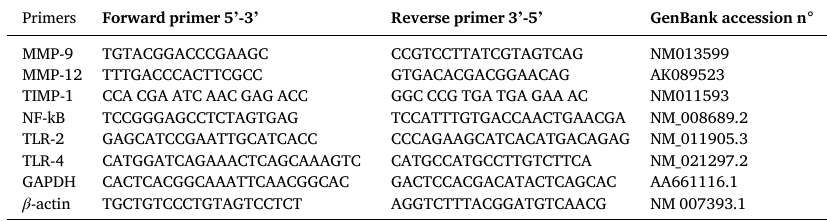
Table 1. Primer sequences used in qRT-PCR.